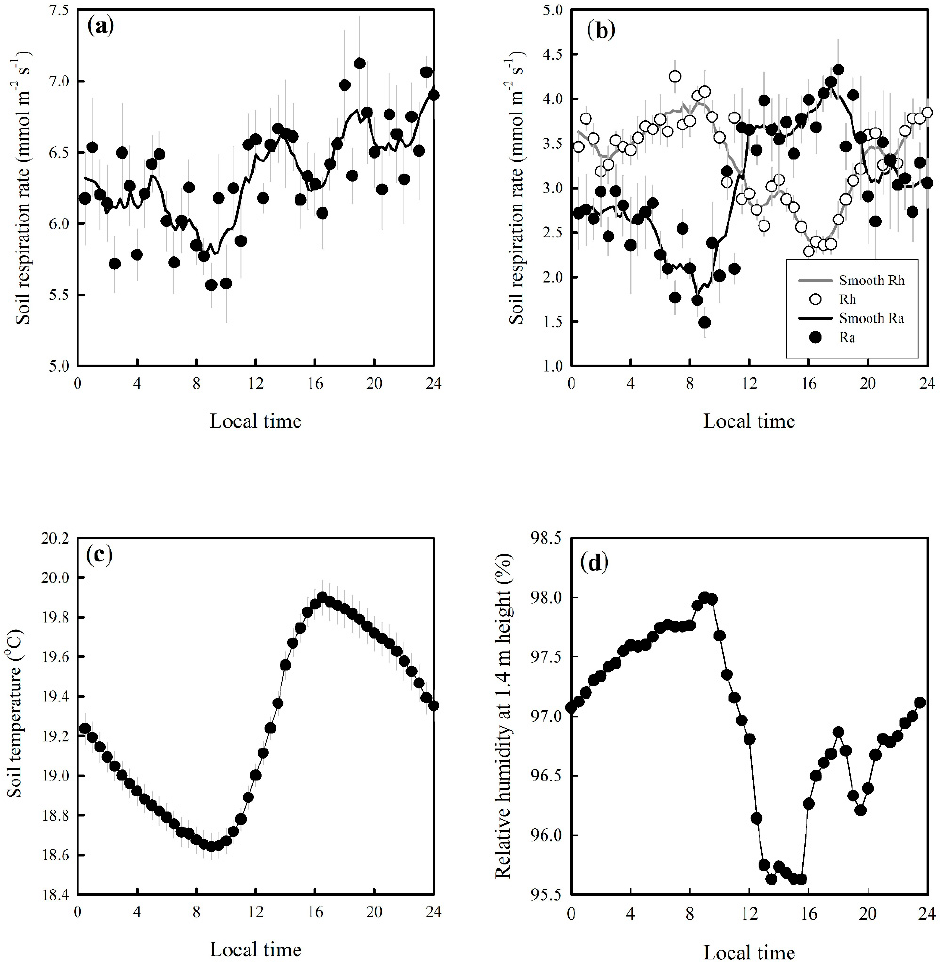
Figure 4. The diurnal variation of soil respiration ( a ), its components ( b ), soil temperature ( c ), and relative humidity of air at 1.4 m height ( d ). R h : heterotrophic respiration in the trenching treatment; R a : autotrophic respiration calculated as the difference between total soil respiration and R h . Error bars indicate the standard deviation.